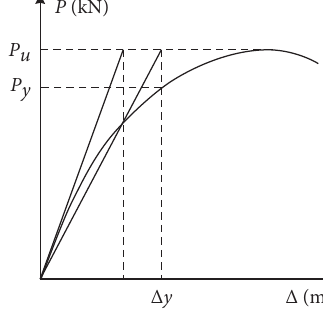
Figure 21: General yield loads method. Table 12: Ductility